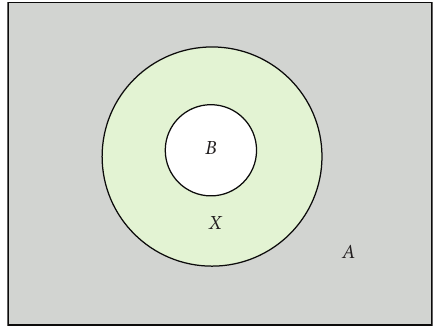
Figure 4: System divided into A , B , and X by subset X .